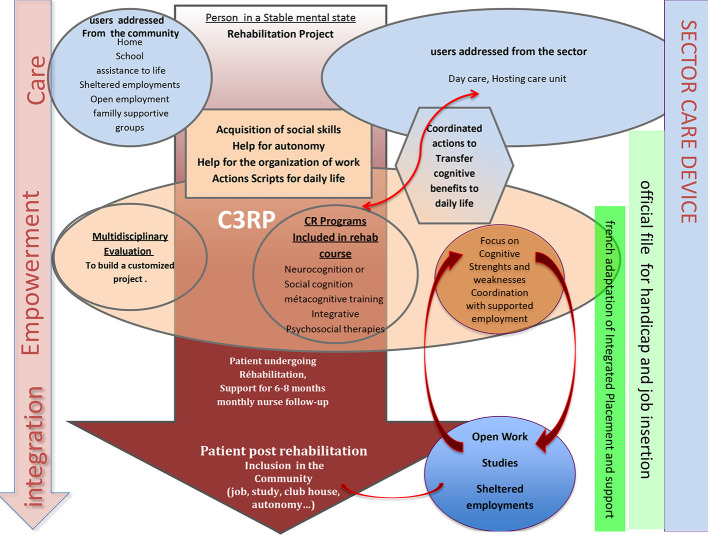
The stepping stone model for empowerment and recovery.